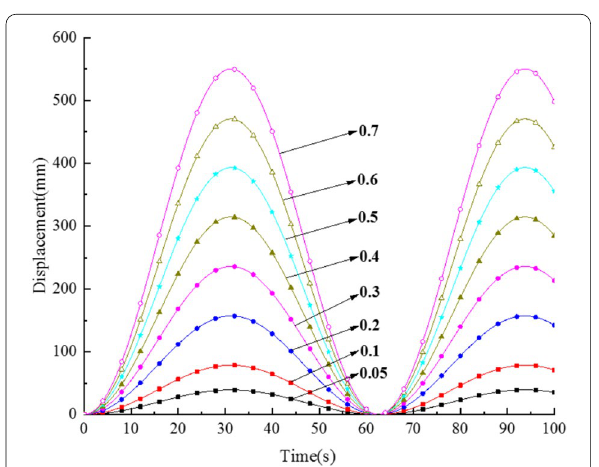
Figure 12 Displacement curve of hydraulic cylinder